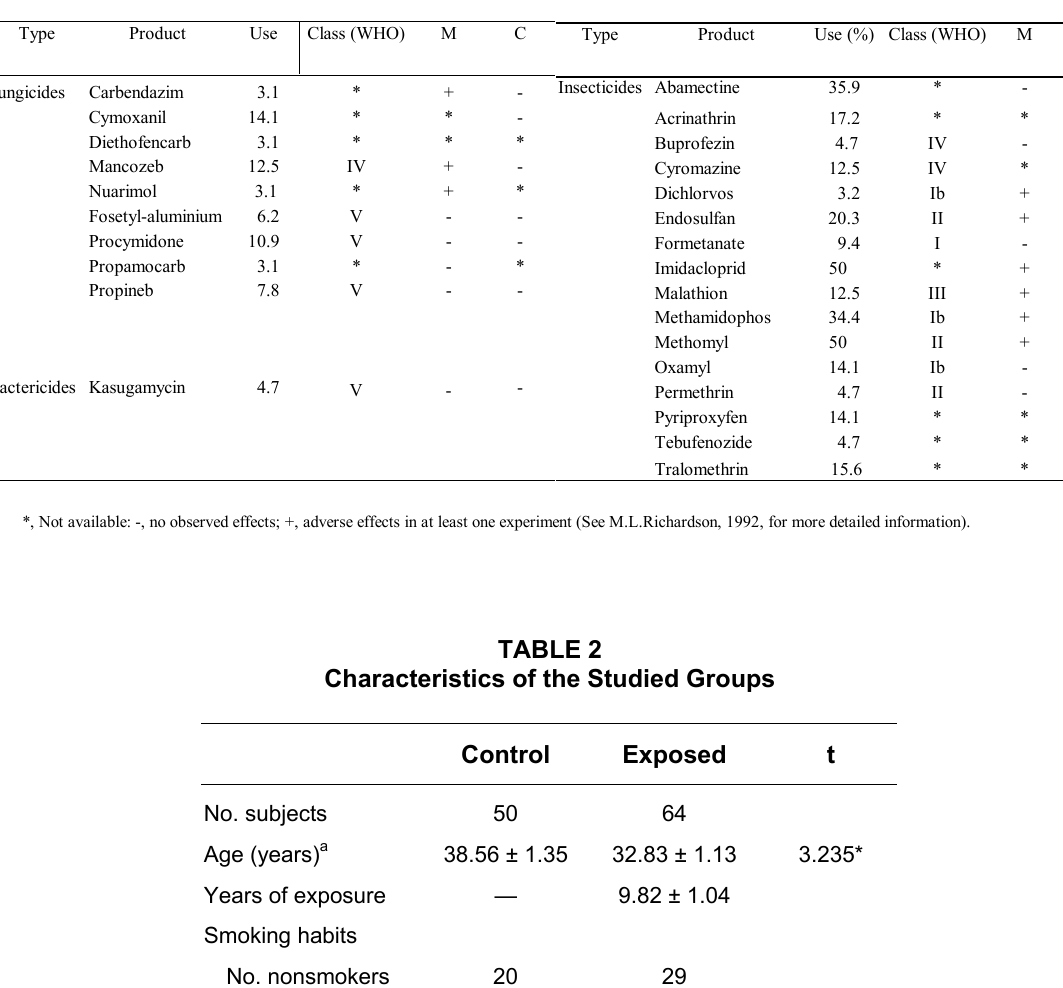
Pesticides used for spraying by the studied group, with indication of their frequencies of use, WHO classification by hazard, and mutagenicity (M) and carcinogenicity (C) experimental data